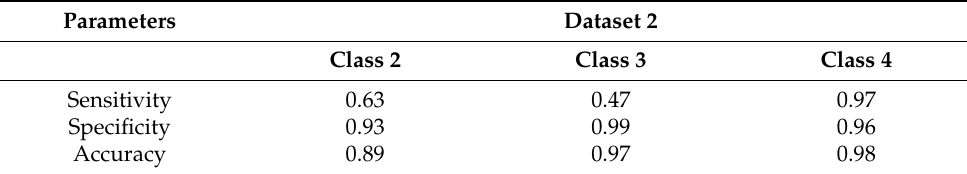
Table 5. Classification of diabetes for dataset 2.